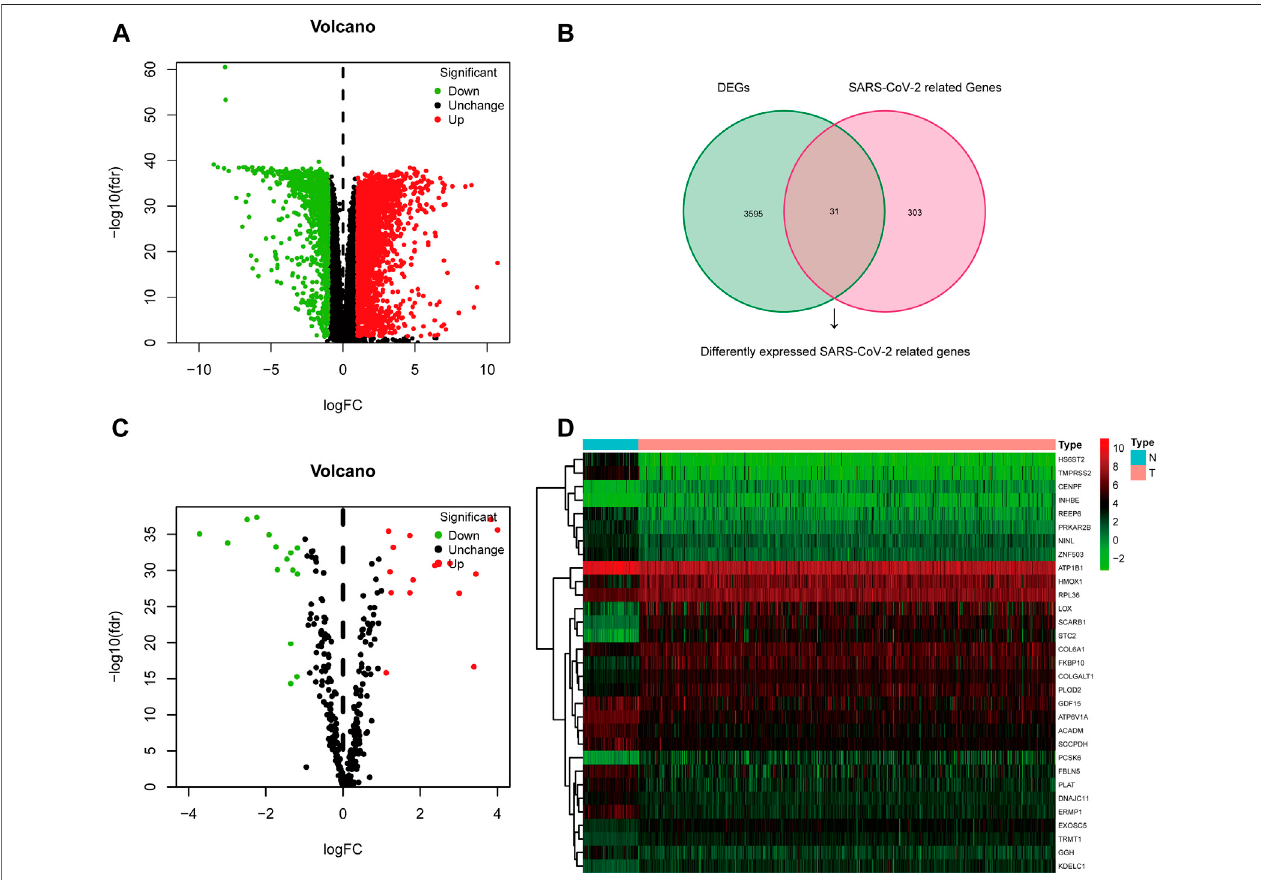
FIGURE2| DifferentiallyexpressedSARS-CoV-2 – relatedgenesinKIRC. (A) VolcanoplotofallDEGs; (B) VenndiagramtoidentifySARS-CoV-2 – relatedDEGs; (C) Volcano plot of 31 SARS-CoV-2 – related DEGs; (D) Heat map of 31 SARS-CoV-2 – related DEGs.